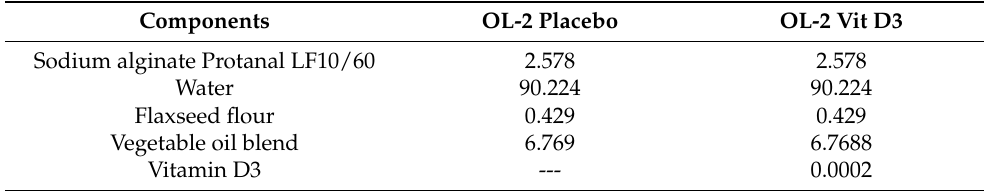
Table 7. Percentage composition of placebo and vit D3-loaded emulsions. Components OL-2